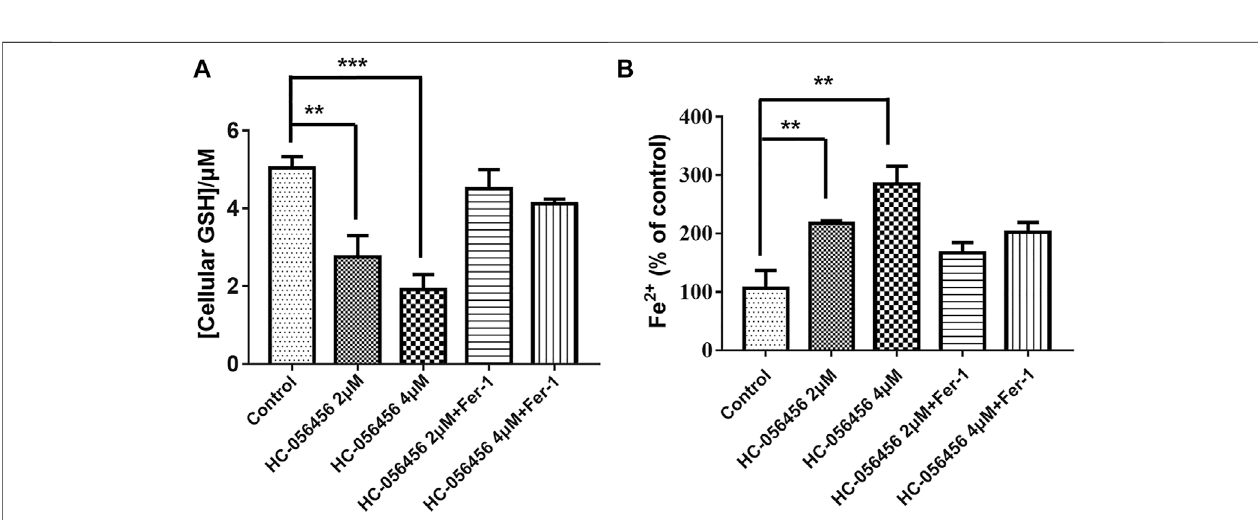
FIGURE5| HC-056456triggeredferroptosisofMGC-803cells (A) ThelevelsofcellularGSHand (B) Fe 2+ weredetected.* p < 0.05,** p < 0.01,*** p < 0.001versus control group.